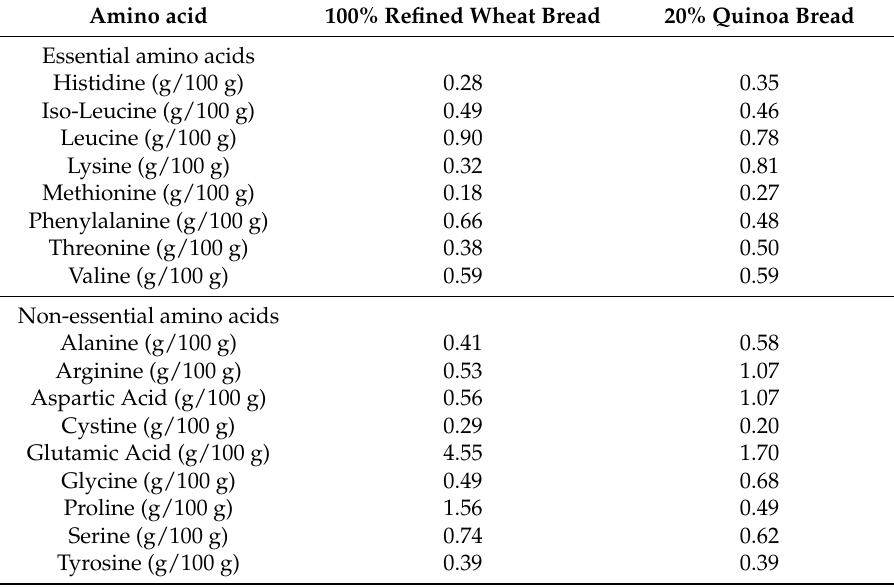
Table 2. Composition of amino acid of refined wheat and quinoa rolls (dry basis) 1